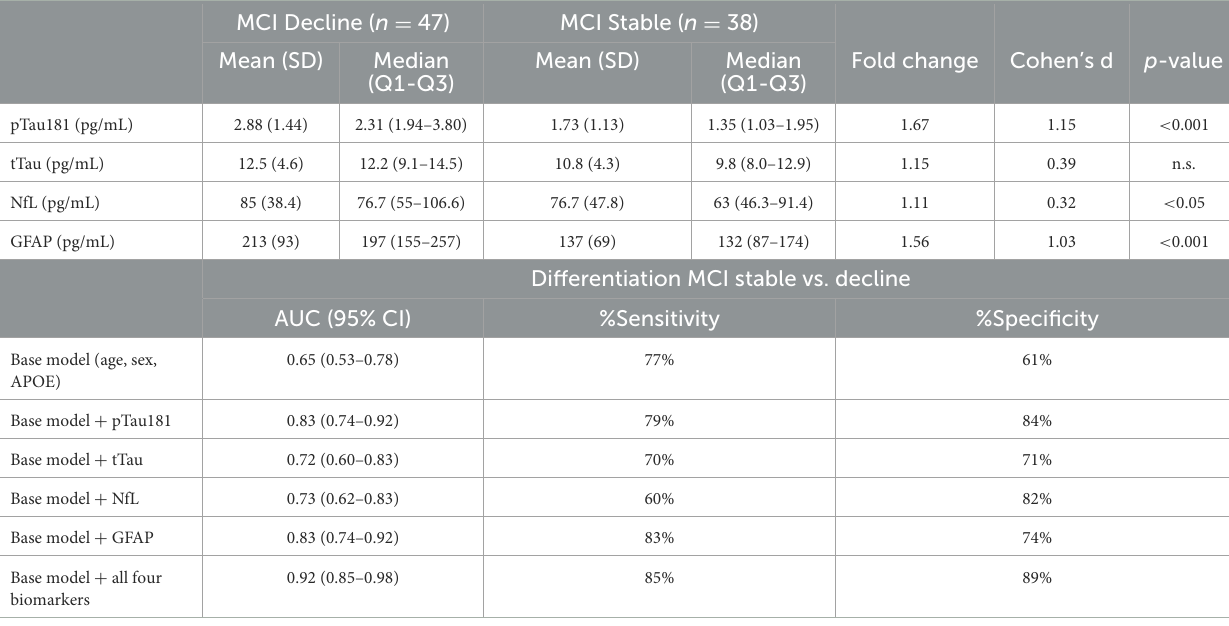
TABLE 3 Clinical performance of the four biomarker assays in Sample A (Longitudinal prognostic sample).